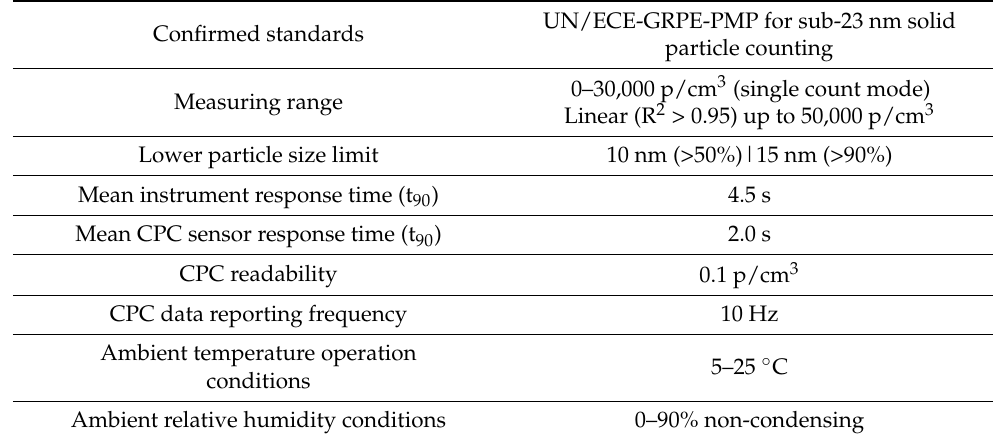
Table 4. AVL Advanced Particle Counter technical characteristics and features.